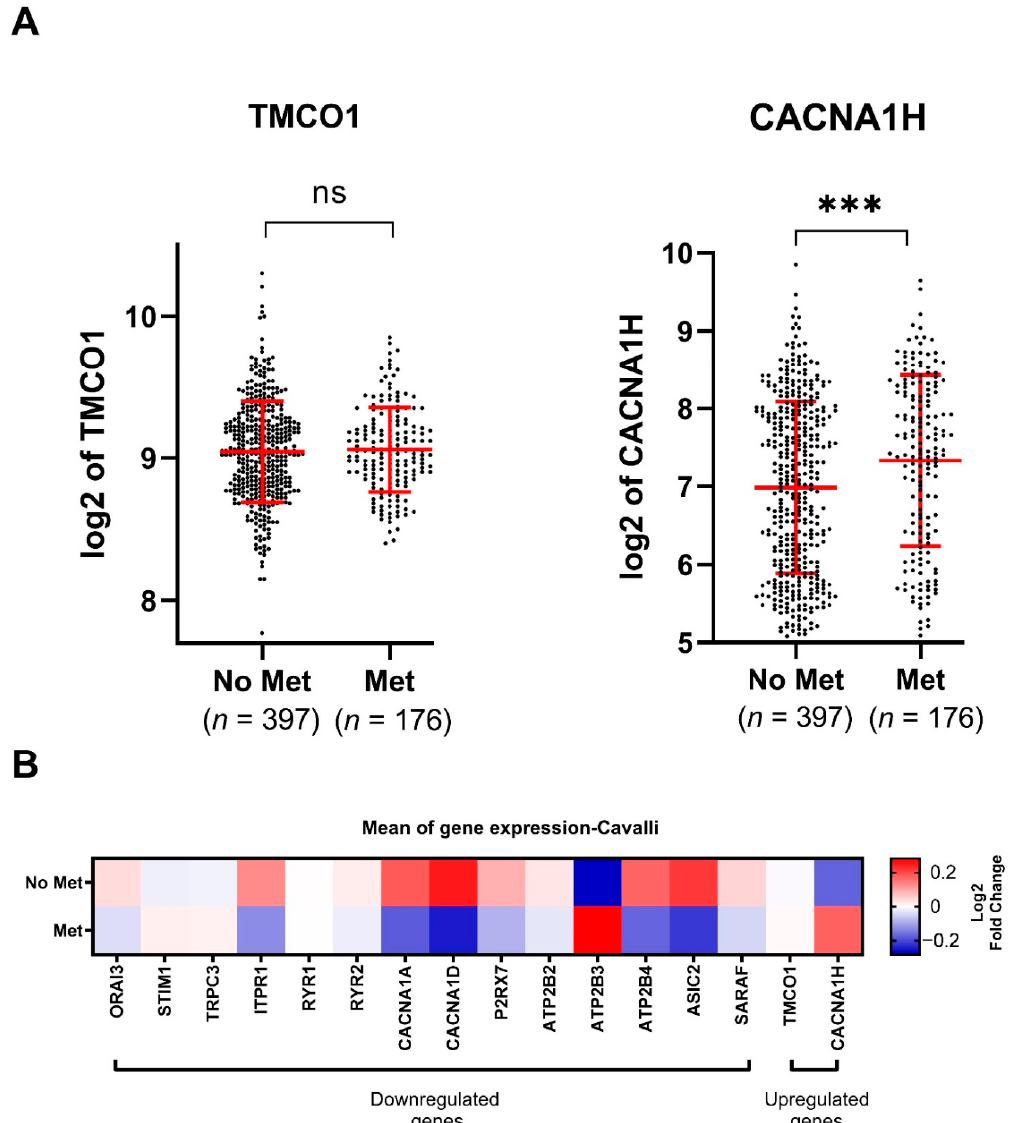
Figure 3. Expression of the identified dysregulated Ca 2+ transporter genes in MB metastasis using the Cavalli dataset [20]: ( A ) TMCO1 and ( B ) CACNA1H (2 upregulated Ca 2+ transporter genes) log 2 transformed mRNA expression in the Cavalli dataset of MB metastatic patients (Met, n = 176) versus non-metastatic patients (No Met, n = 397). Data were exported from R2 Genomics software and plotted in GraphPad PRISM. ns: not significant p > 0.05, *** p- value < 0.001, two-tailed unpaired non-parametric t -test, with Mann Whitney test, mean with SD; ( C ) heatmap representing the mean expression of the 16 identified Ca 2+ transporter genes in MB metastatic patients compared to MB non-metastatic patients.